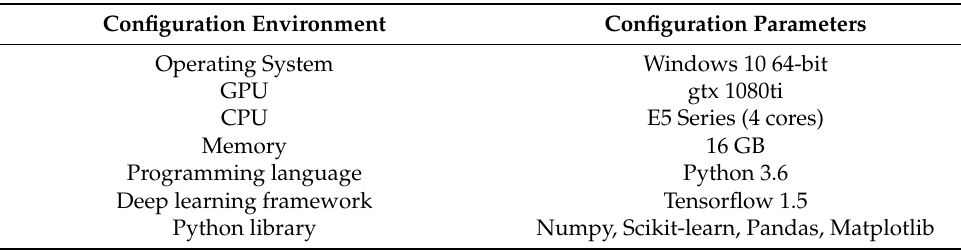
Table 3. Description of the experimental